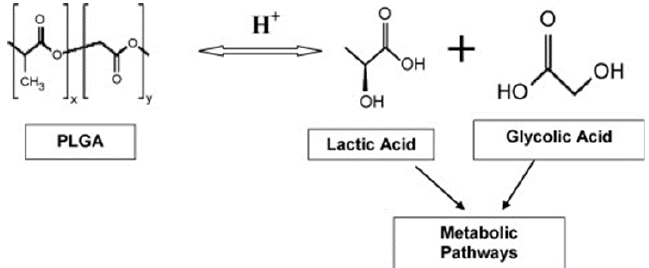
Figure 2. Overview of hydrolysis of poly(lactic-co-glycolic acid) (Reprinted from [117]. Copyright (2010), with permission from Elsevier).